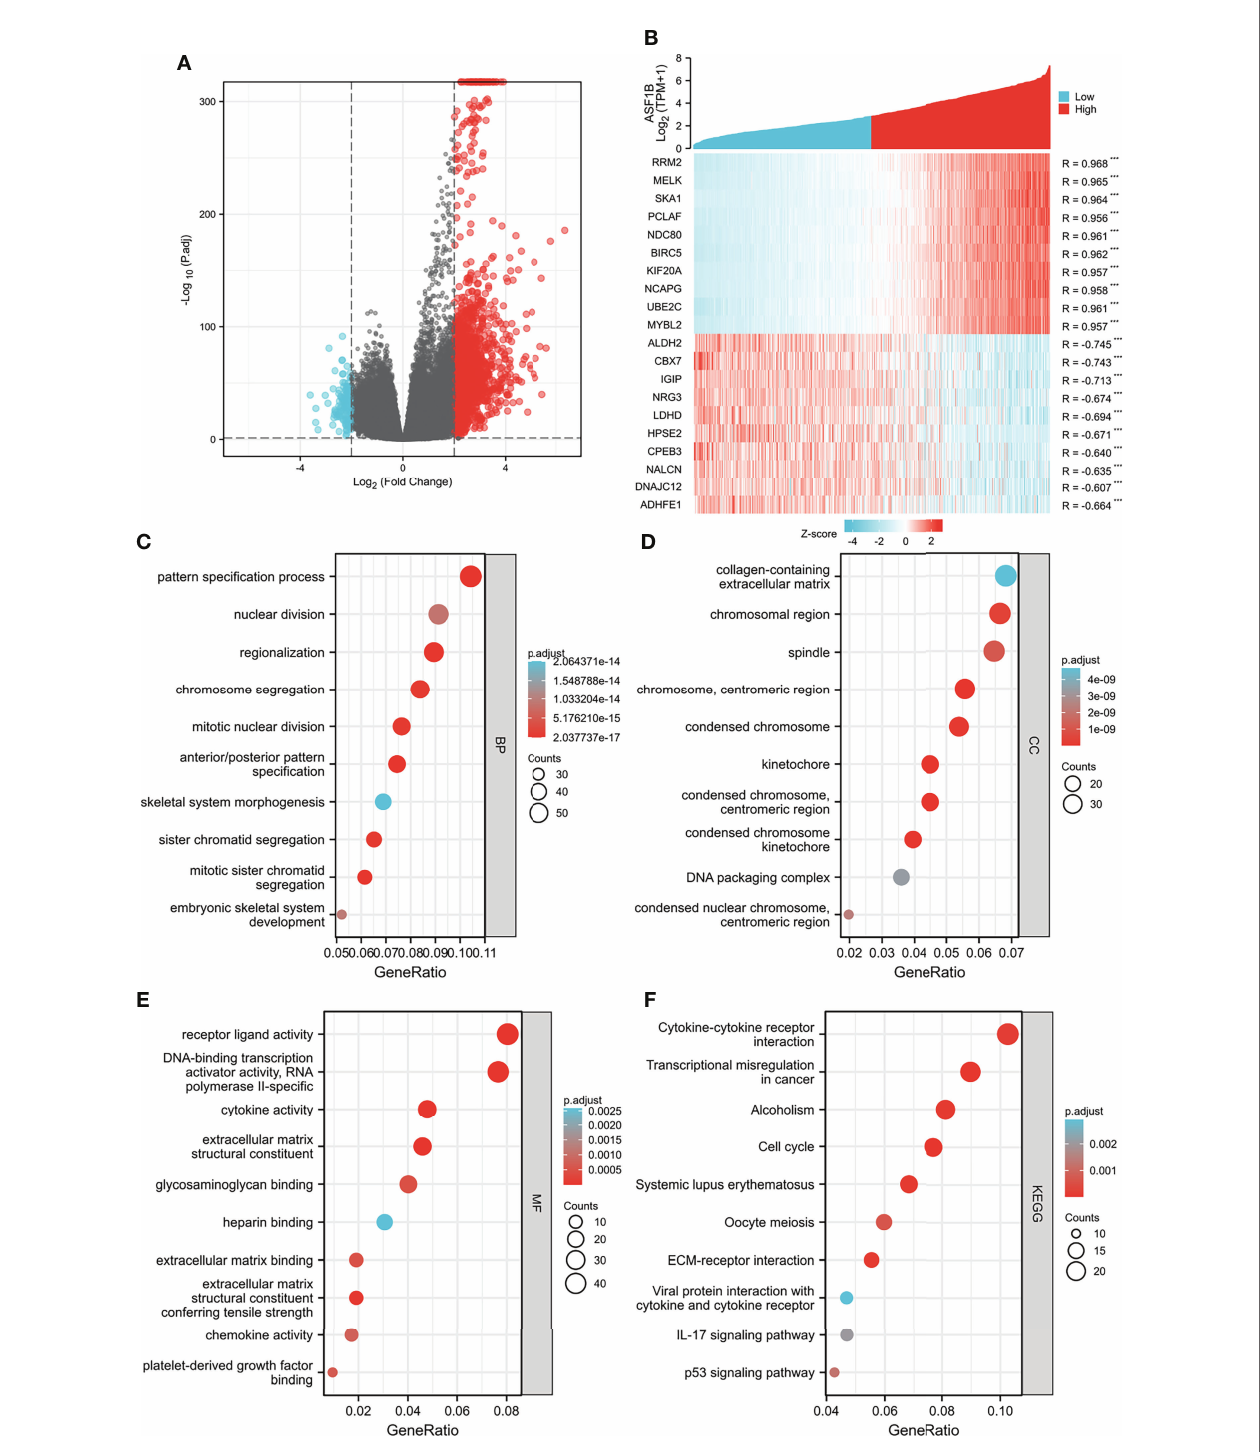
FIGURE 5 | Functional enrichment analysis for ASF1B expression in glioma patients from the TCGA database. (A) Volcano Plot of differentially expressed genes (DEGs) screened based on ASF1B expression. (B) The top 10 positively correlated genes and the top 10 negatively correlated genes cotranscript with ASF1B in gliomas. (C – F) Enrichment analysis showed the biological processes (BP) (C) , cellular components (CC) (D) , molecular function (MF) (E) , and KEGG pathway analysis (F) of DEGs screened based on ASF1B expression. *** p <